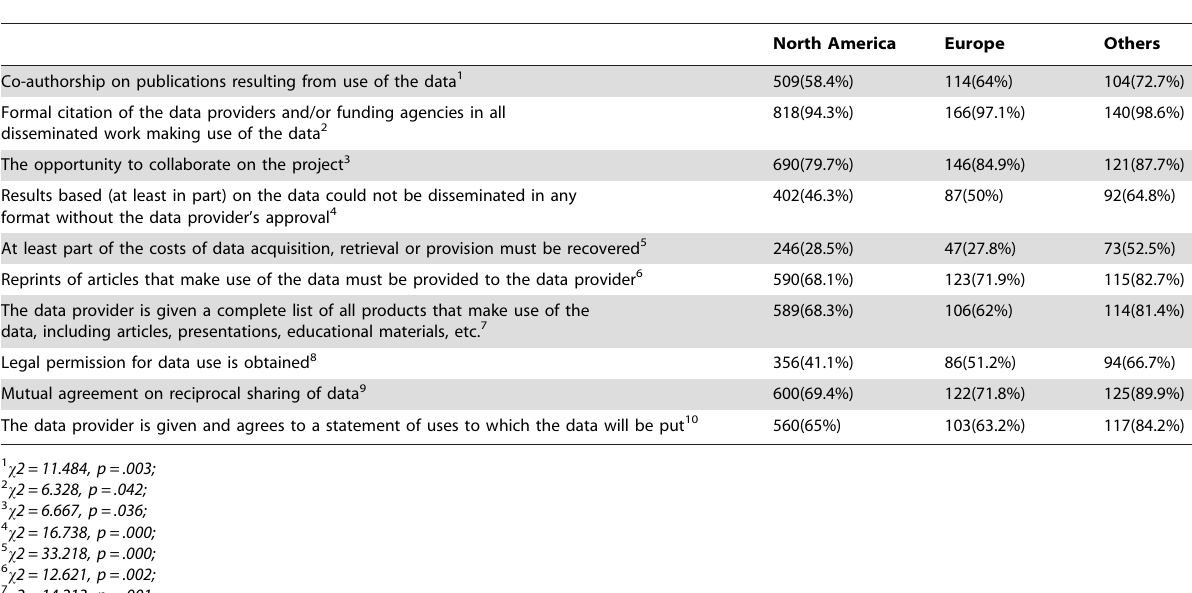
Table 37. Using others’ data by geographic